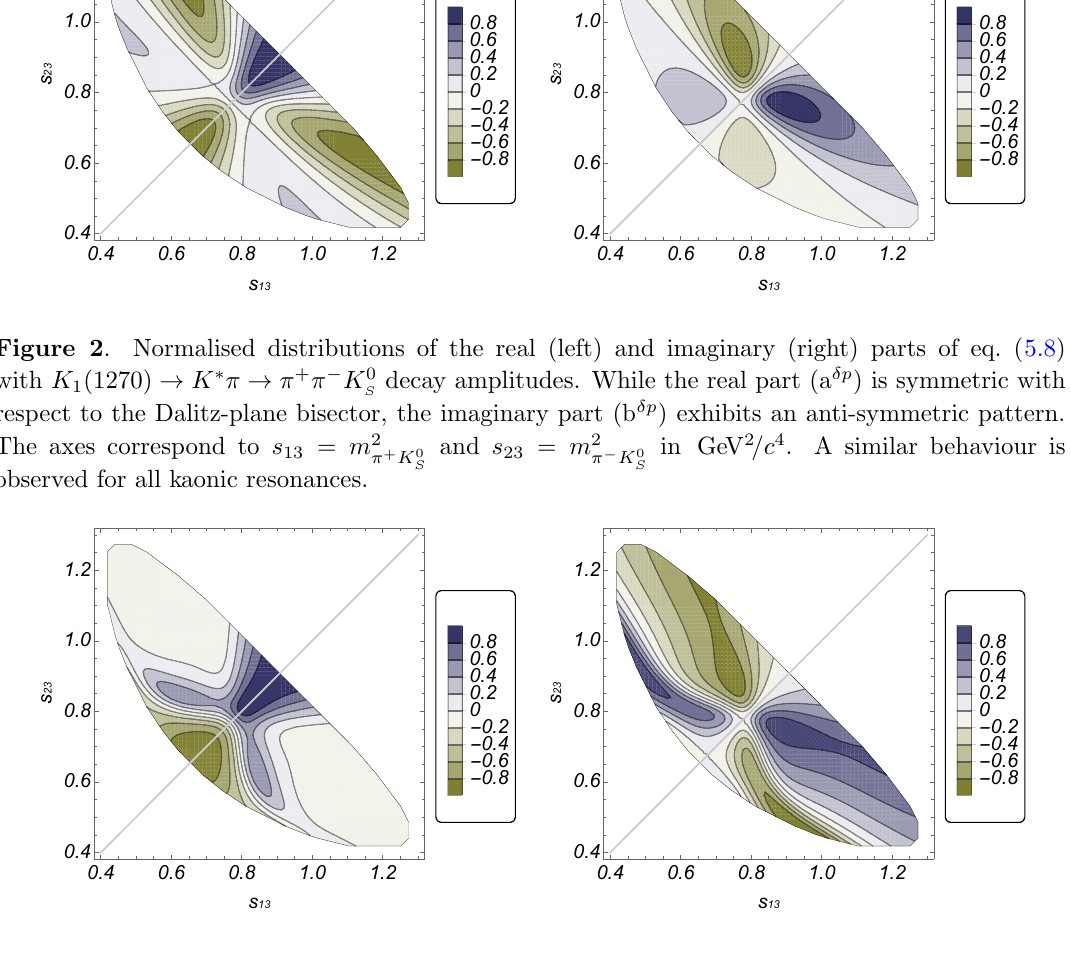
Figure 3 . Normalised distributions of the real (left) and imaginary (right) parts of eq. (5.8) decay amplitudes, including all the intermediate resonances. The axes with K 1 (1270) π + π − K 0 S → and s 23 = m 2 in GeV 2 /c 4 . A similar behaviour is observed for all correspond to s 13 = m 2 π + K 0 S π − K 0 S kaonic